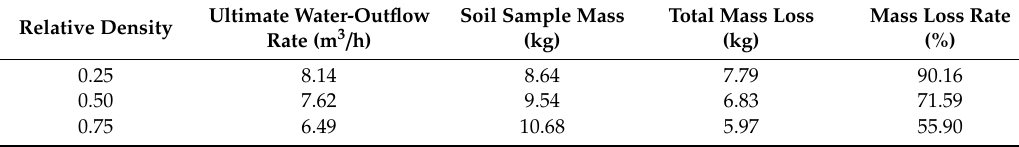
Figure 10. Variation tendency of monitoring objects’ characteristic value with relative density ( D r ). ( a ) Occurrence time of Transition Point I, II along with relative density; ( b ) Ultimate water-outflow rate along with relative density; ( c ) Mass loss rate along with relative density. Table 7. Variation of monitoring objects’ characteristic value with relative density ( D r